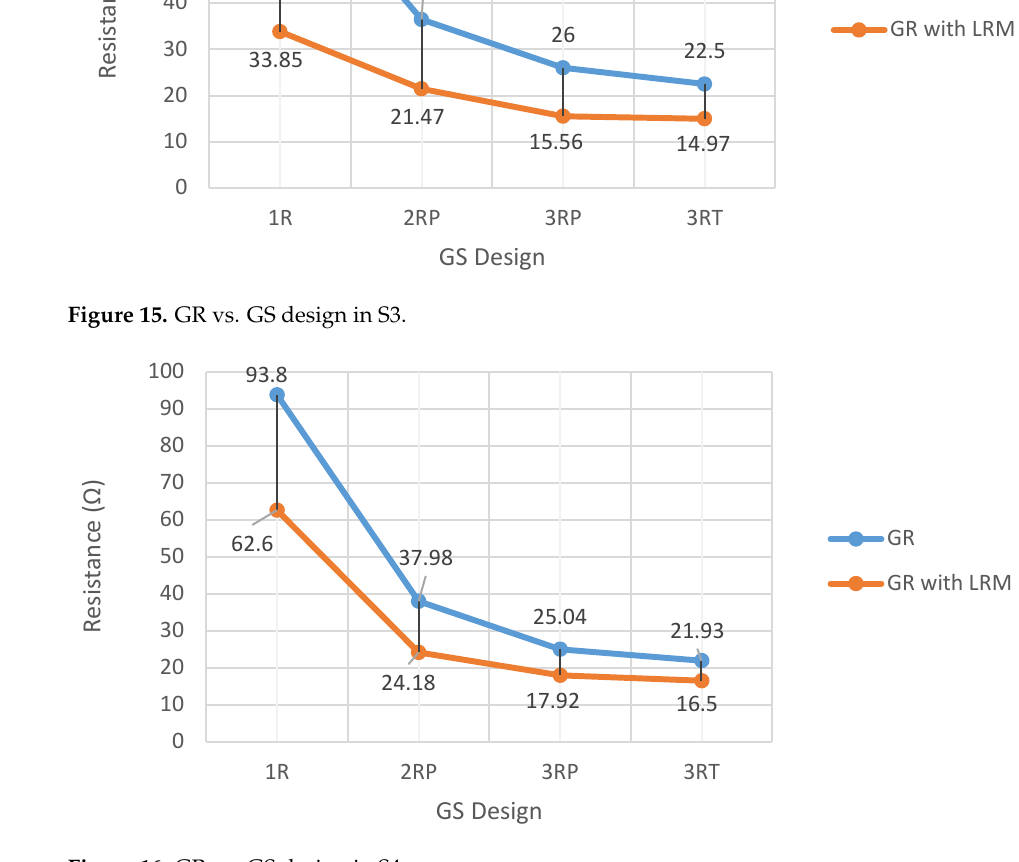
Figure 16. GR vs. GS design in